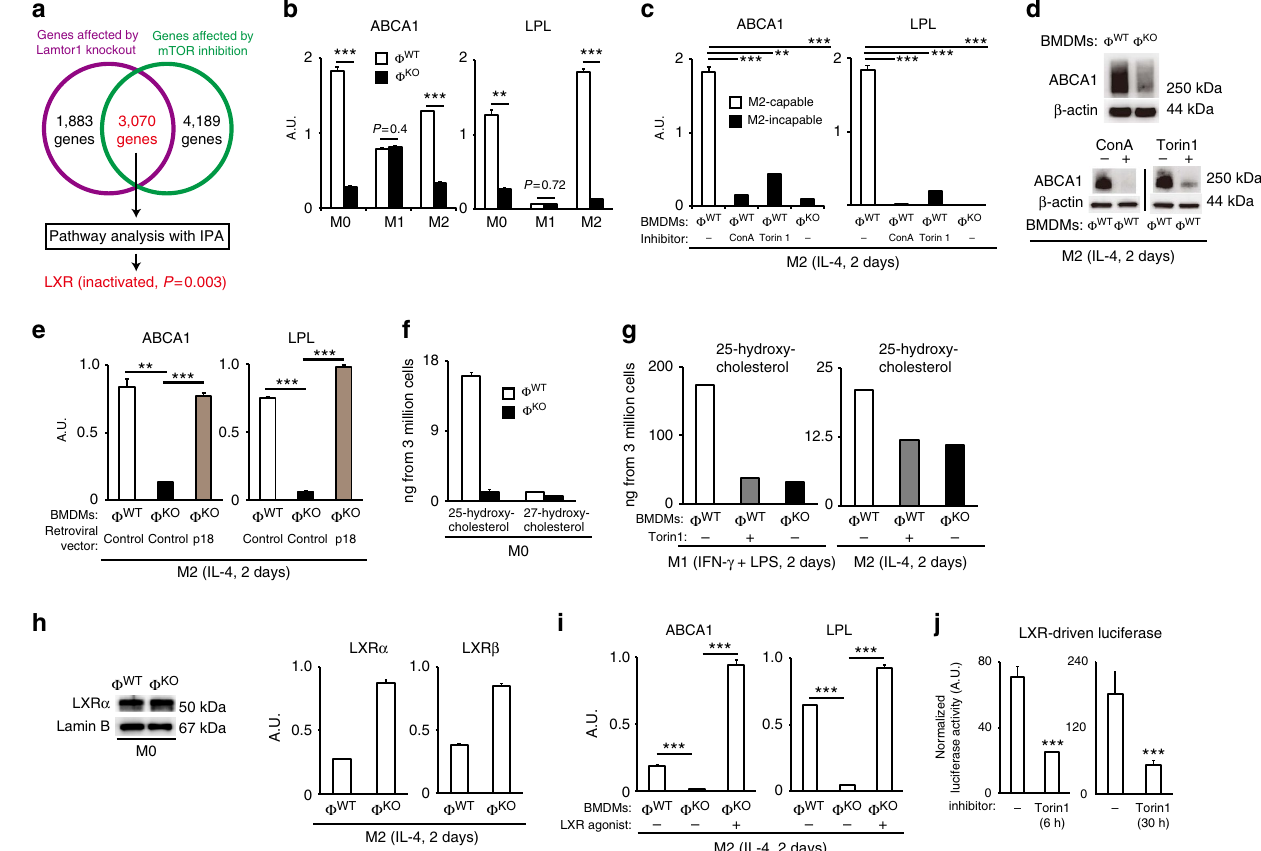
Figure 6 | LXR is the downstream target of Lamtor1 and mTOR. ( a ) Strategy to find the downstream pathway of Lamtor1 and mTORC1. Numbers of genes whose expression levels were changed equal or more than 2-fold in gene expression microarray are shown as a Venn diagram. The 3,070 genes affected by both Lamtor1-loss and mTOR-inhibition were input to gene enrichment analysis program in a commercially available pathway analysis software IPA; Inactivation of LXR was suggested. See Supplementary Data 1 for the list of genes in each group. ( b ) Real-time PCR for LXR-target genes ABCA1 and LPL. M0 BMDMs were at resting condition; M1 BMDMs were stimulated with 20ngml (cid:2) 1 of IFN- g and 100ngml (cid:2) 1 of LPS for 2 days; M2 BMDMs were stimulated with 50ngml (cid:2) 1 of IL-4 for 2 days. ( c ) Real-time PCR for LXR (cid:2) target genes. Expression of these genes was decreased in BMDMs that could not polarize to M2M F s. ( d ) Western blot for ABCA1. Knockout of Lamtor1, treatment with a v-ATPase inhibitor or an mTOR inhibitor decreased expression of ABCA1 protein in IL-4 (cid:2) stimulated BMDMs. ( e ) Real-time PCR for LXR-target genes. Re-introduction of Lamtor1 gene into Lamtor1-deficient BMDMs rescued expression of ABCA1 and LPL during M2-polarizing stimulation. The control retroviral vector expressed GFP protein. ( f ) Intracellular amounts of endogenous LXR ligands oxysterols were measured by mass spectrometry. ( g ) Intracellular amounts of 25-hydroxycholesterol were measured after M1- of M2-polarizing stimulation. ( h ) Western blot for nuclear LXR a in M0 macrophages (left panel); and real-time PCR for LXR a and LXR b in IL-4 (cid:2) stimulated BMDMs. ( i ) Real-time PCR showed that an LXR agonist GW3965, used in combination with its obligatory heterodimer RXR’s ligand 9-cis retinoic acid, rescued expression of LXR-target genes in Lamtor1-deficient BMDMs. ( j ) Luciferase assay in HEK293 cells showed that mTOR is required for LXR activity. Cells transfected with LXR (cid:2) driven luciferase and control constitutively-active luciferase were treated with an mTOR inhibitor. ConA: concanamycin A. F WT and F KO are defined as in Fig. 1. * P o 0.05, ** P o 0.01, *** P o 0.001. Error bars show